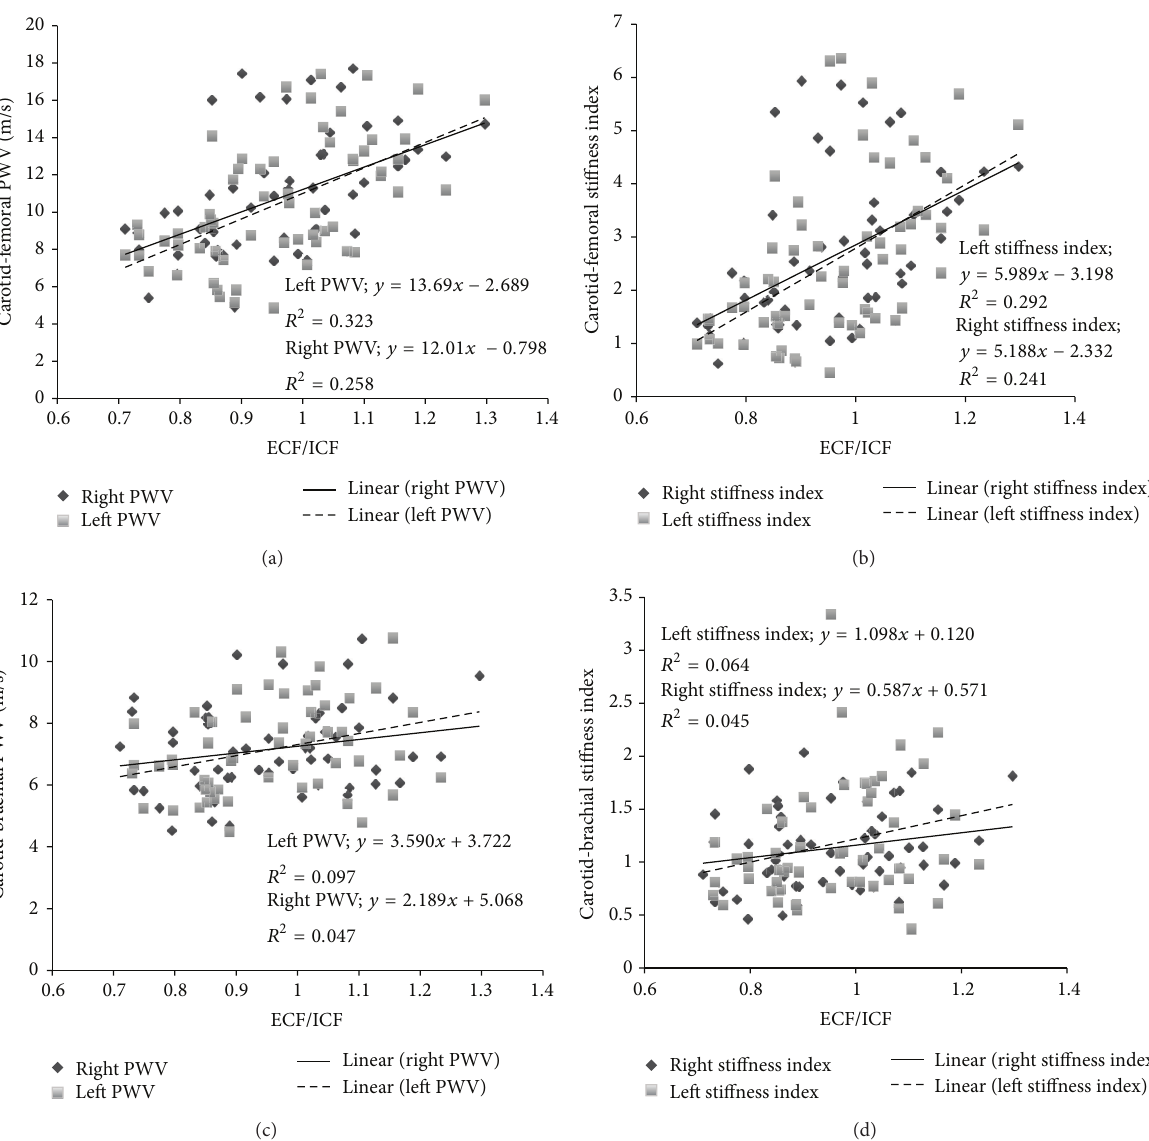
Figure 1: Pulse wave velocity (PWV) and hydration status evaluated through extracellular/intracellular fluid ratio (ECF/ICF) measured using a multi-impedancimetric technique. The carotid-femoral PWV-ECF/ICF relationship shows a significant relationship ( 𝑃 < 0.05 ), as does the stiffness index ( 𝛽 )-ECF/ICF relationship ( 𝑃 < 0.05